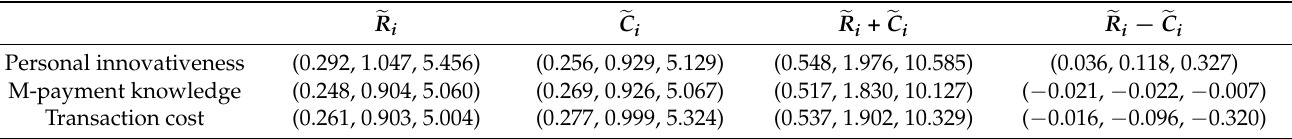
def def and ( (cid:101) R i − (cid:101) C i ) impacts using the three criteria of the individ-